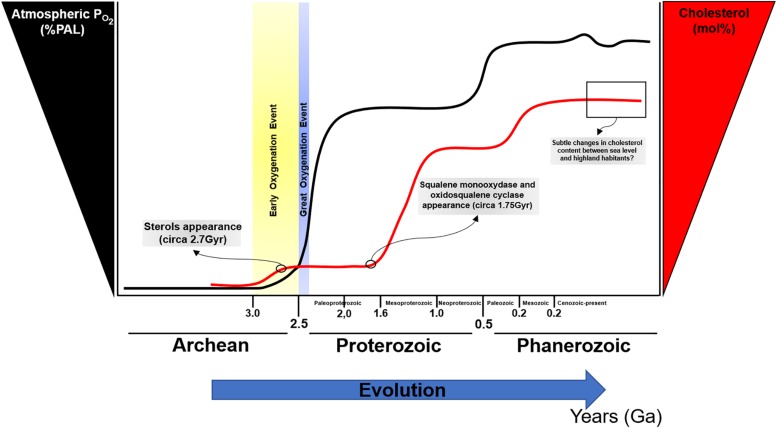
Oxygen and cholesterol changes during evolution. PAL, present atmospheric level. Modified from [opetwcite]B96,B107[clotwcite]Kump (2008); Lyons et al. (2014), and Gold et al. (2017).